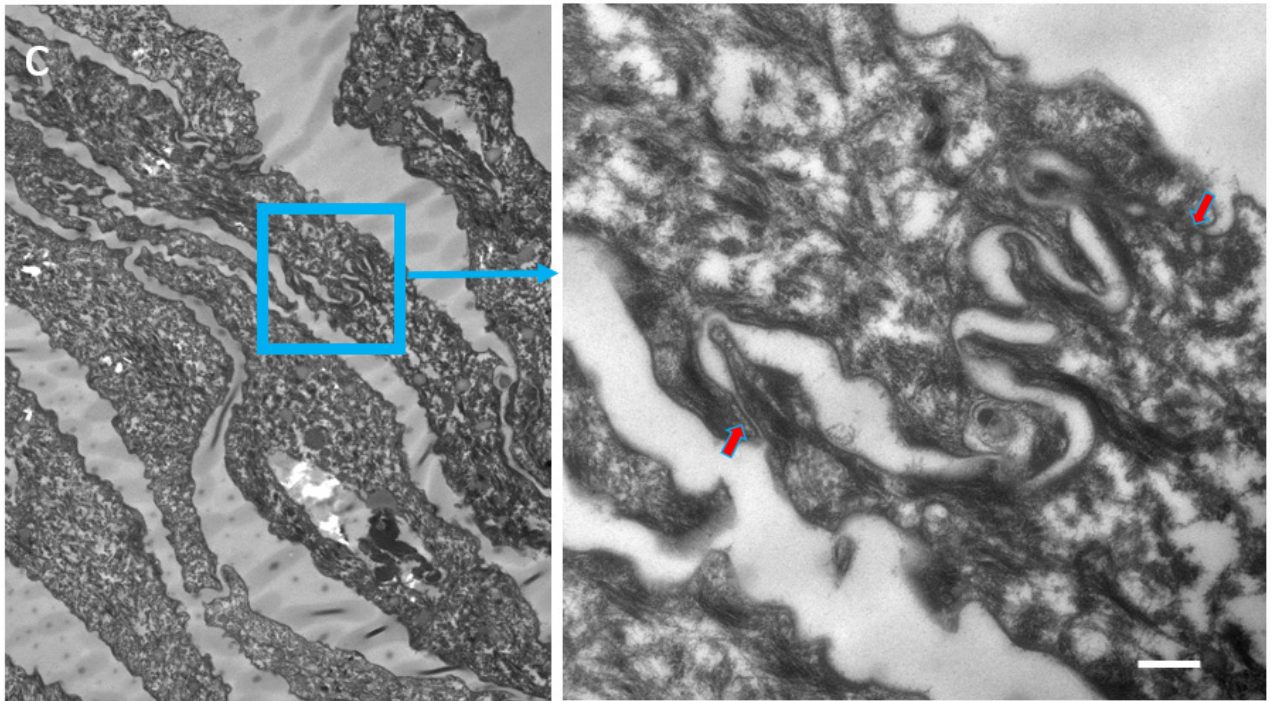
Figure 2. Ultrastructural features of SC in patients with IHSC include problems related to lipid extrusion ( a ), abnormal convolution of cell walls, and increased retention of TJ-derived intercorneocyte rivets ( b , c ). TJ-derived fusion points between the lateral walls of cornified cells persist up to the surface of hyperkeratotic SC, shown in ( c ), where corneodesmosomes are no longer present. Arrows point to TJ remnants isolating the extracellular space between adjacent uppermost corneocytes. In ( c ), the right panel shows a high power view of the SC disjunctum area delimited by the rectangle to the left. d = (corneo)desmosome; red arrows = TJ-derived structure. Bars = 200 nm. Table 3. Increased presence of fused TJ remnants in the SC of IHSC. TJ-derived fusions within the apical-lateral contacts of corneocytes were counted in the first four layers of SC. At least 100 apical- lateral contacts were examined at high magnification on several ultrafine sections of each specimen. NHS = normal human